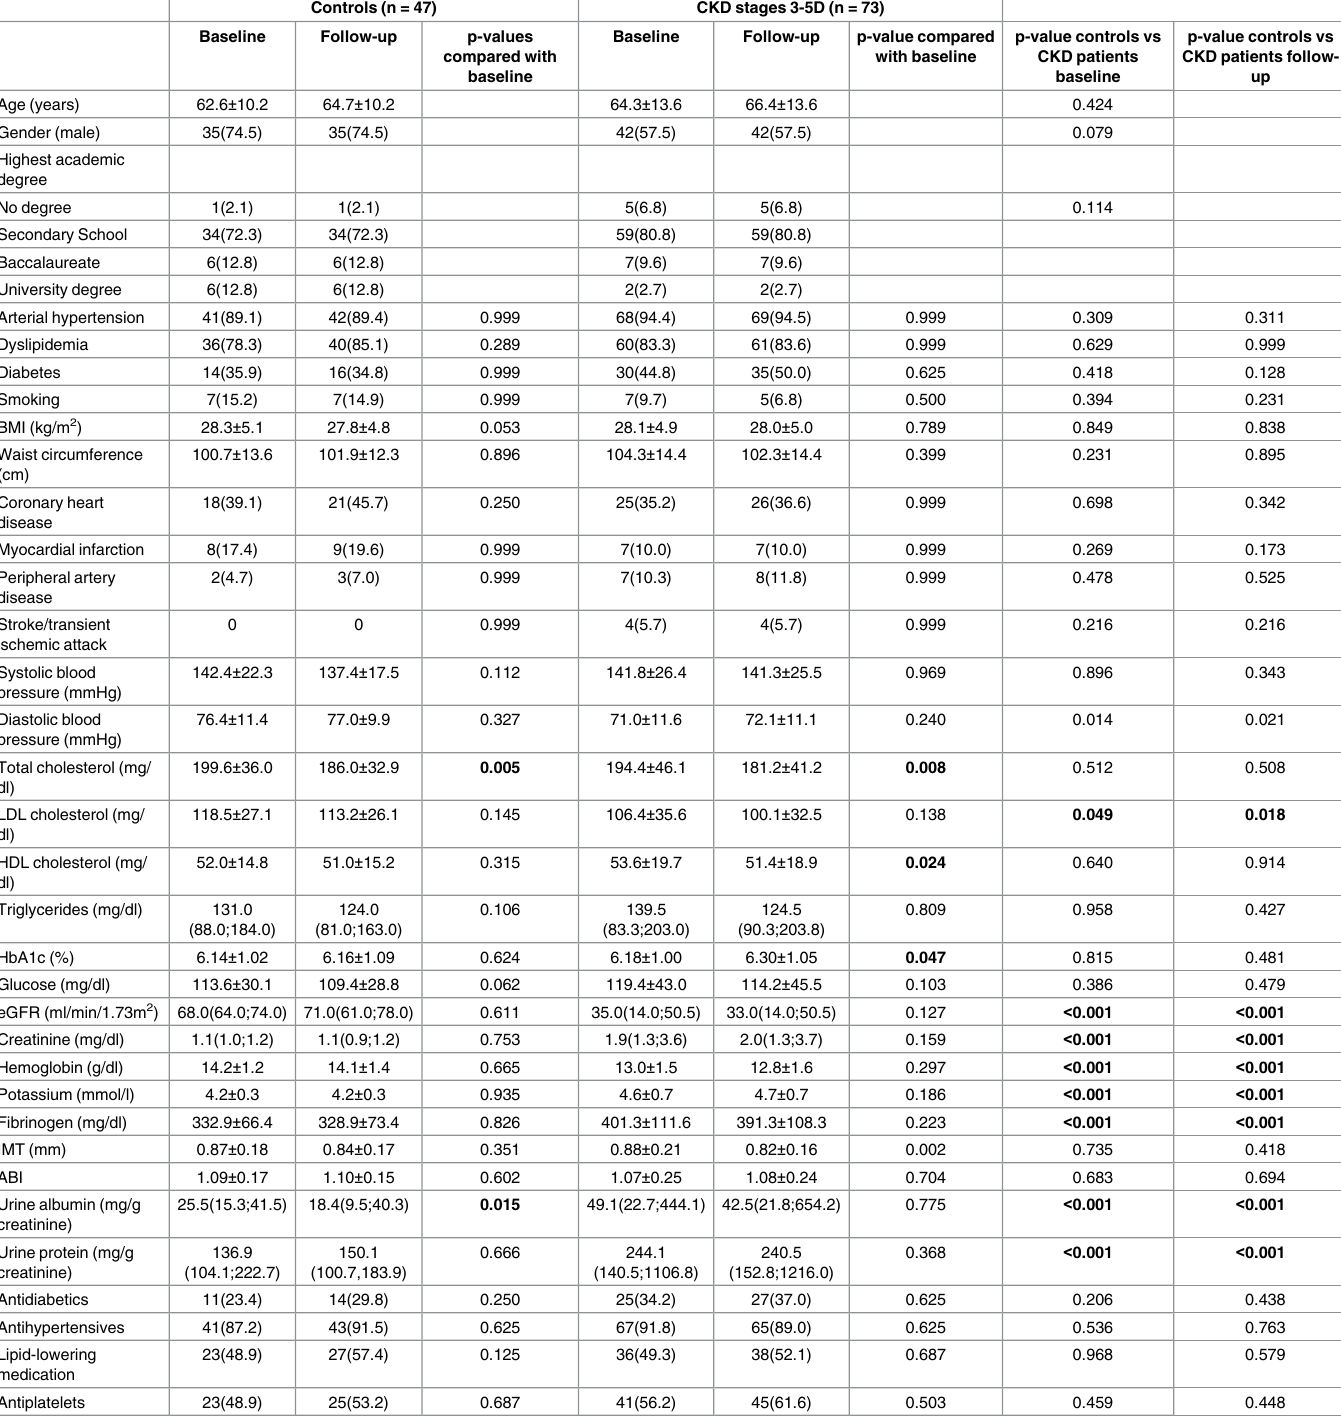
Table 1. Charateristics of Control Patients and CKD Patients at Baseline and